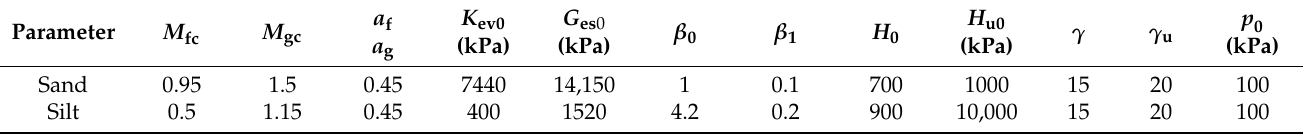
Table 3. Parameters used in the Pastor–Zienkiewicz III models.